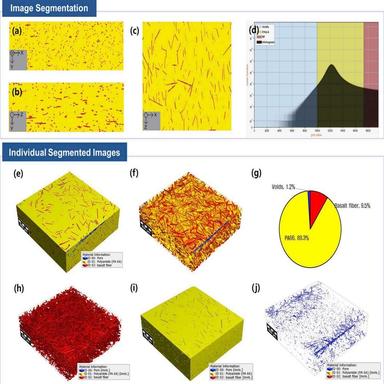
Color thresholding procedures for image segmentation. Three projection images onto the (a) XY plane, (b) YZ plane, and (c) ZX plane. (d) Image segmentation from gray-level values. (e) External and (f) internal microstructure of the SBF/PA6,6 composites. (g) Component volume fraction. Individual segmented components of the SBF/PA6,6 composites: (h) SBF; (i) PA6,6; and (j) voids. (For interpretation of the references to color in this figure legend, the reader is referred to the Web version of this article.)